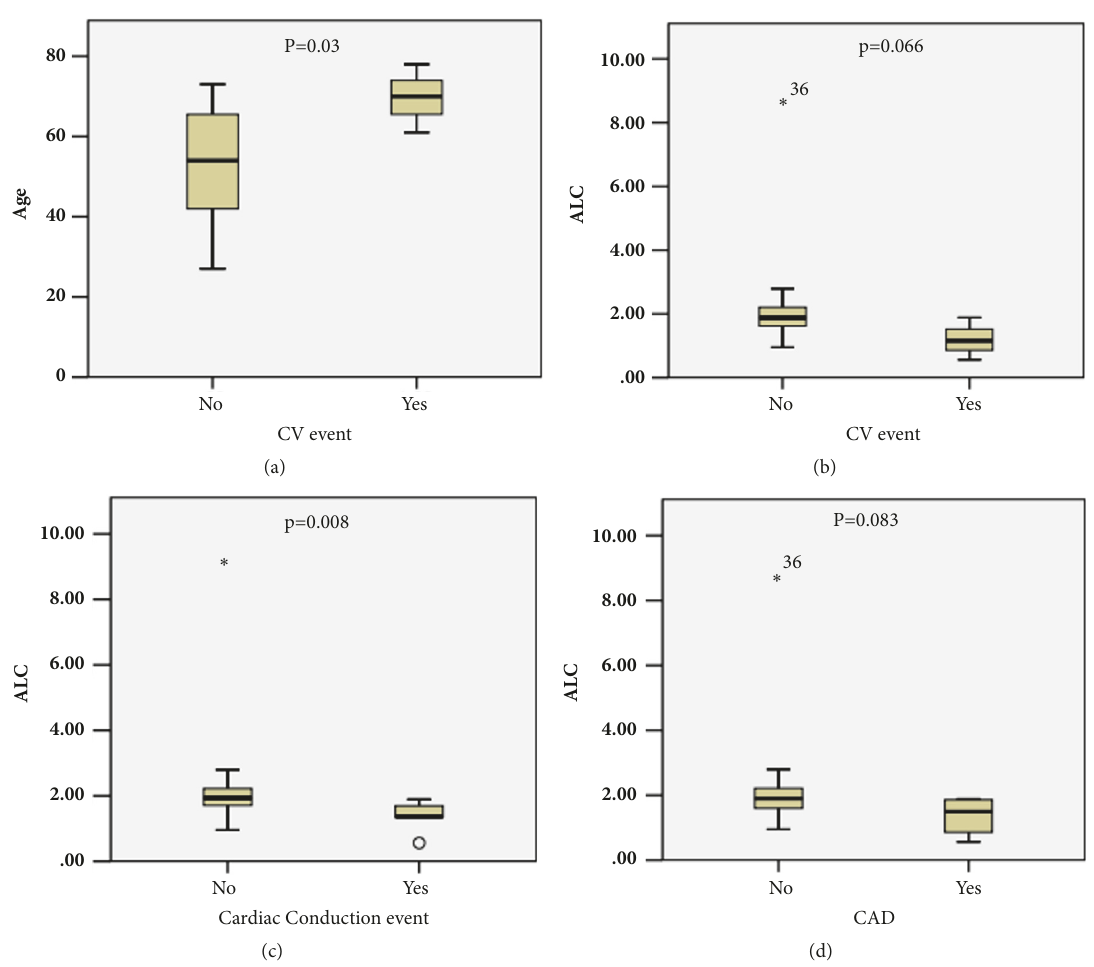
Figure 3: Age and ALC correlations with CVD. (a) Age is associated with CVD events. (b) ALC is nearly associated with CVD events. (c) ALC is significantly associated with conduction abnormalities. (d) ALC is nearly correlated with